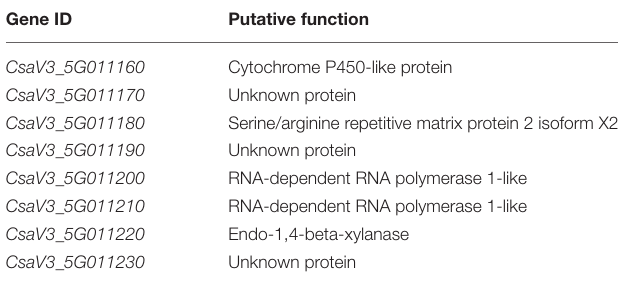
TABLE 2 | Molecular markers used to define the interval for CsCvy-1 locus using F 1 hybrids.